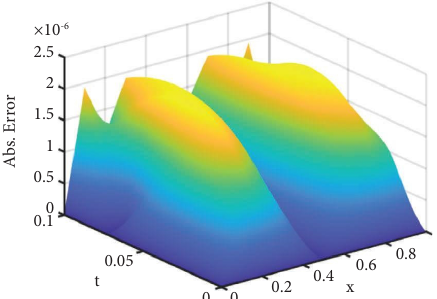
Figure 3: Absolute errors of Example 1 at T � 0 . 1 with h � 0 . 0005, c � 0 . 72, v � 0 . 1, k � 10, and α � 0 .